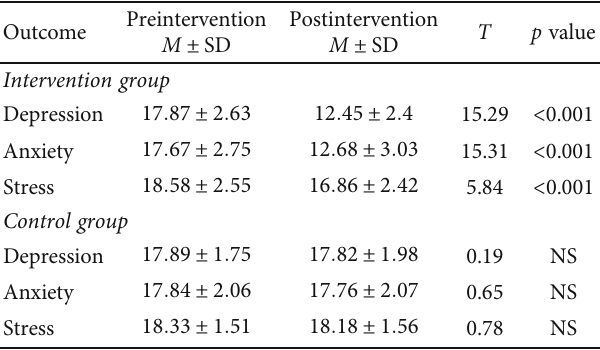
Table 3: Paired samples t -tests between baseline and follow-up measurements for the intervention and control groups.